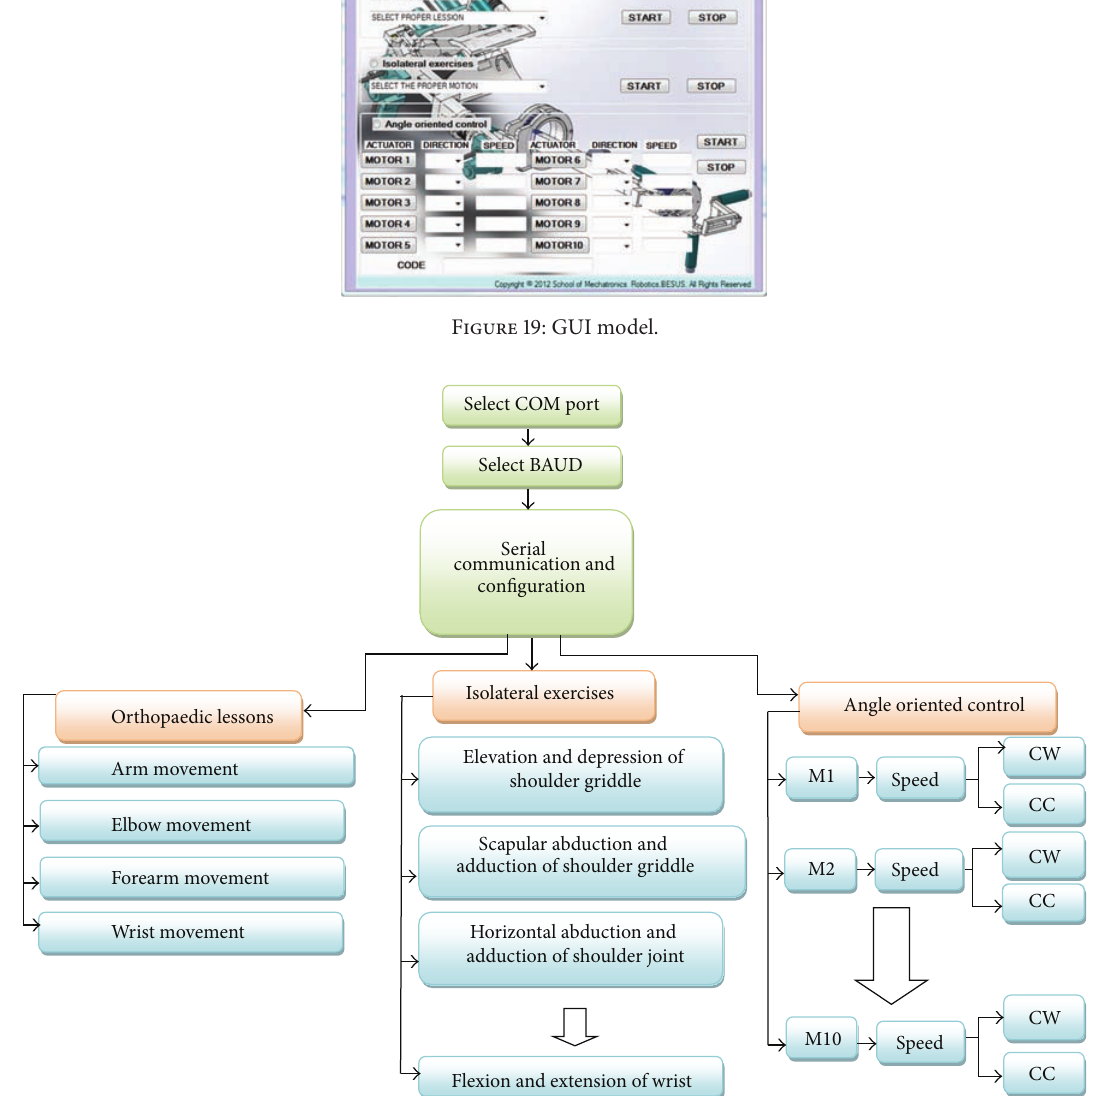
Figure 20: Flow chart of GUI